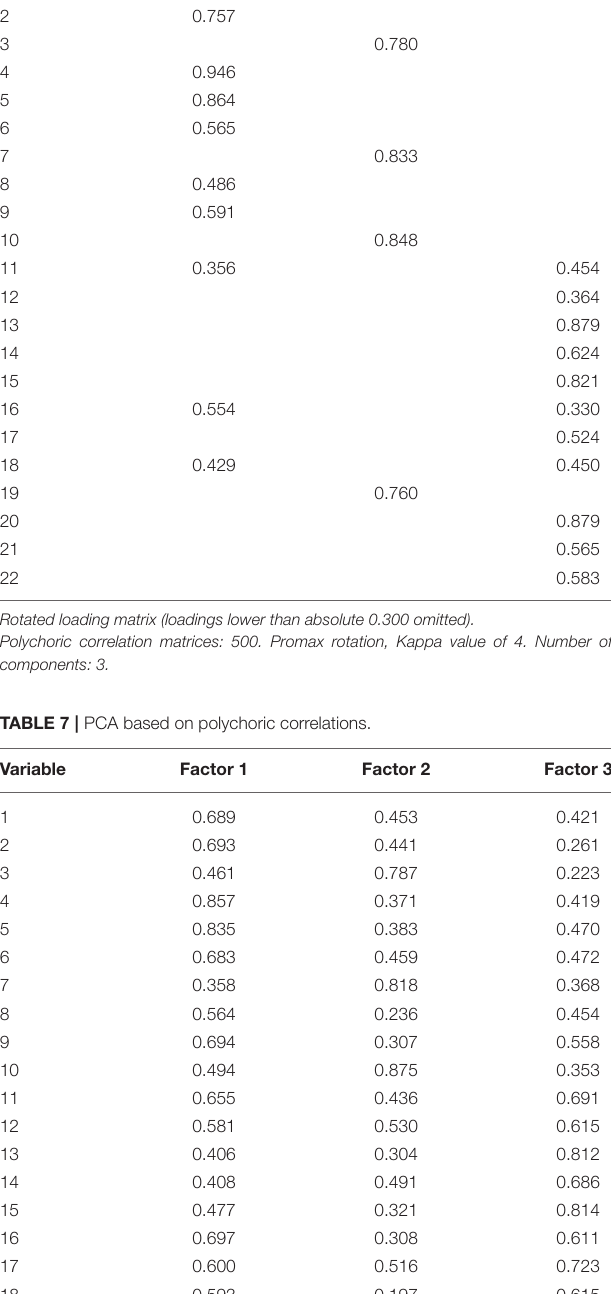
TABLE 6 | PCA based on polychoric correlations. TABLE 5 | Parallel analysis based on principal components analysis of the TMD. Variable Real-data Mean 95 percentile Variable Factor 1 Factor 2 Factor 3 Cumulative eigenvalues eigenvalues of random proportion eigenvalues of variance